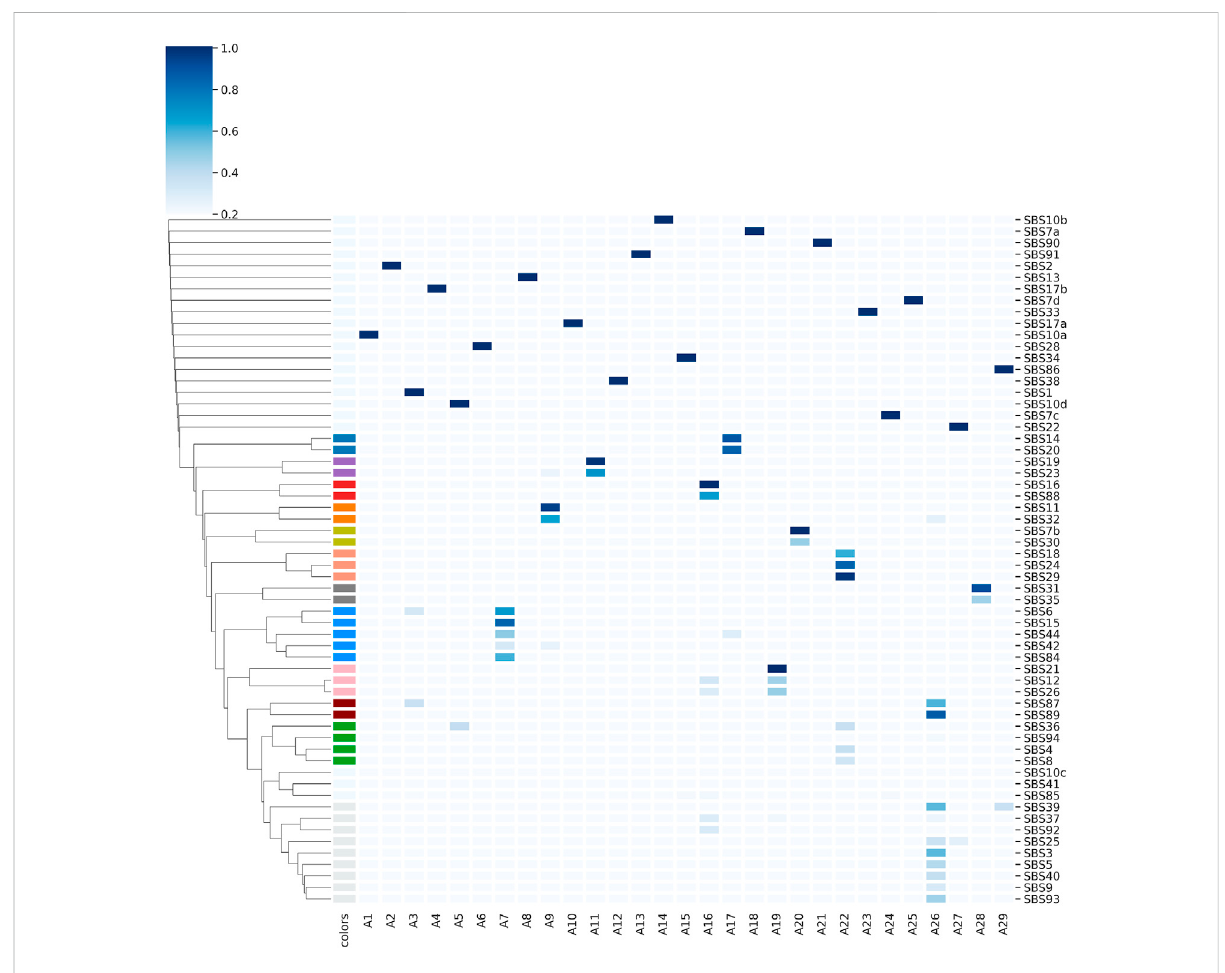
FIGURE 5 Heatmap highlighting the associations between archetypes and the reconstructed signatures. Different colors highlight groups of reconstructed signatures that are mainly represented by the same archetype. For a better visualisation, α coef fi cients < 0.2, even if used for clustering, were not